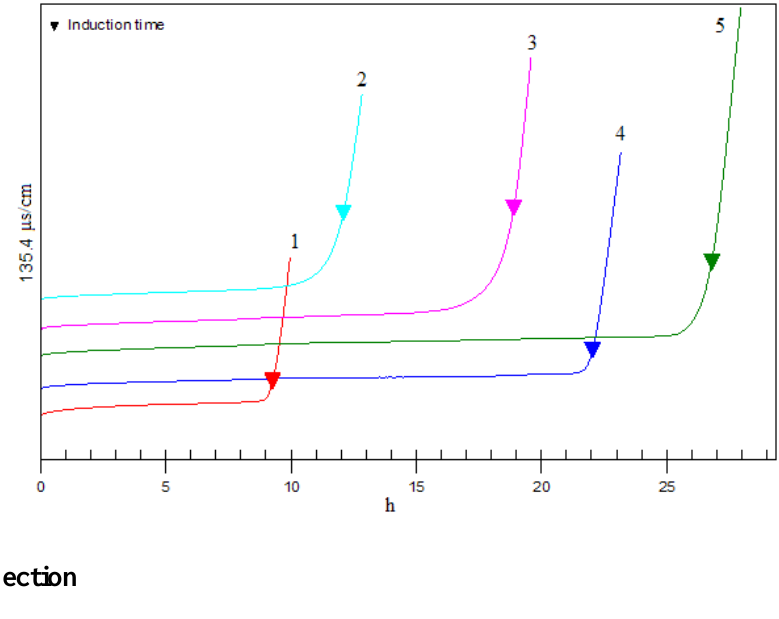
Figure 7. Rancimat antioxidant activity of antioxidant activity of control (1), 0.02% complex (2), 0.04% complex (3), 0.02% BHT (4) and 0.06% complex